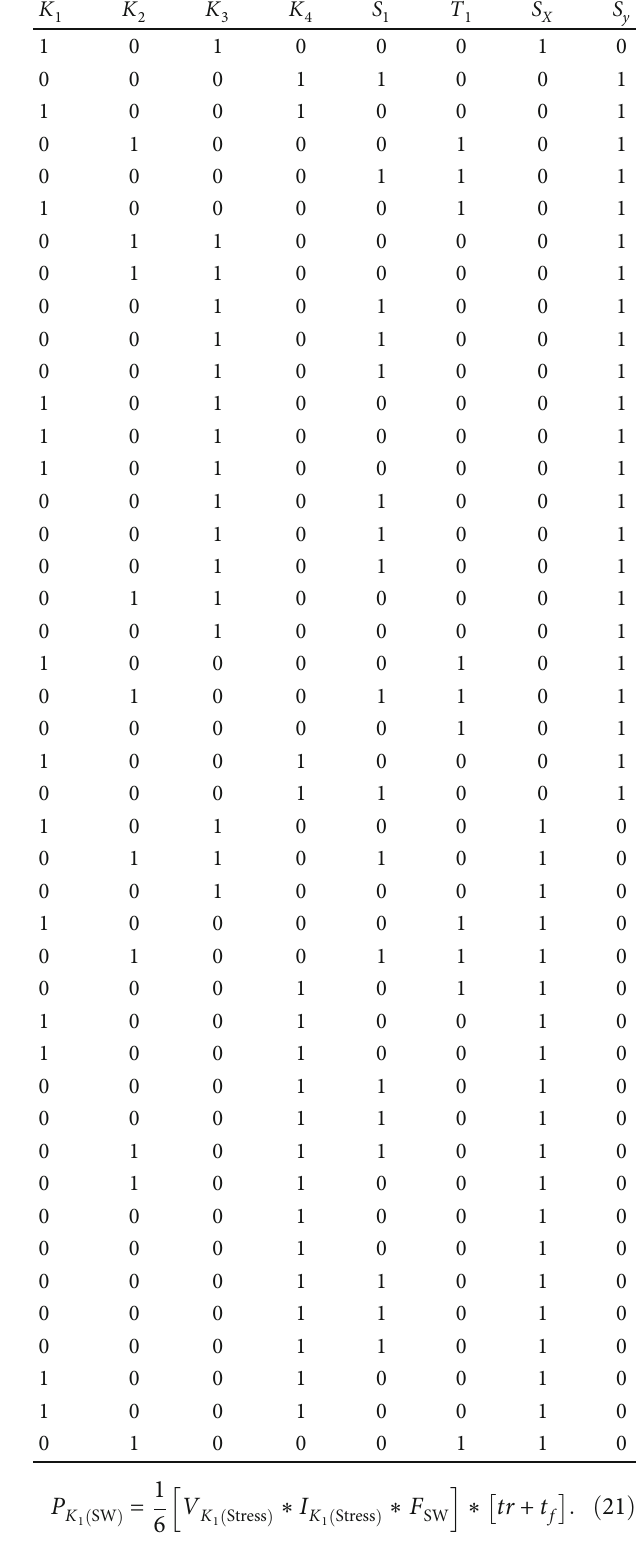
Table 2: Switching sequence of an